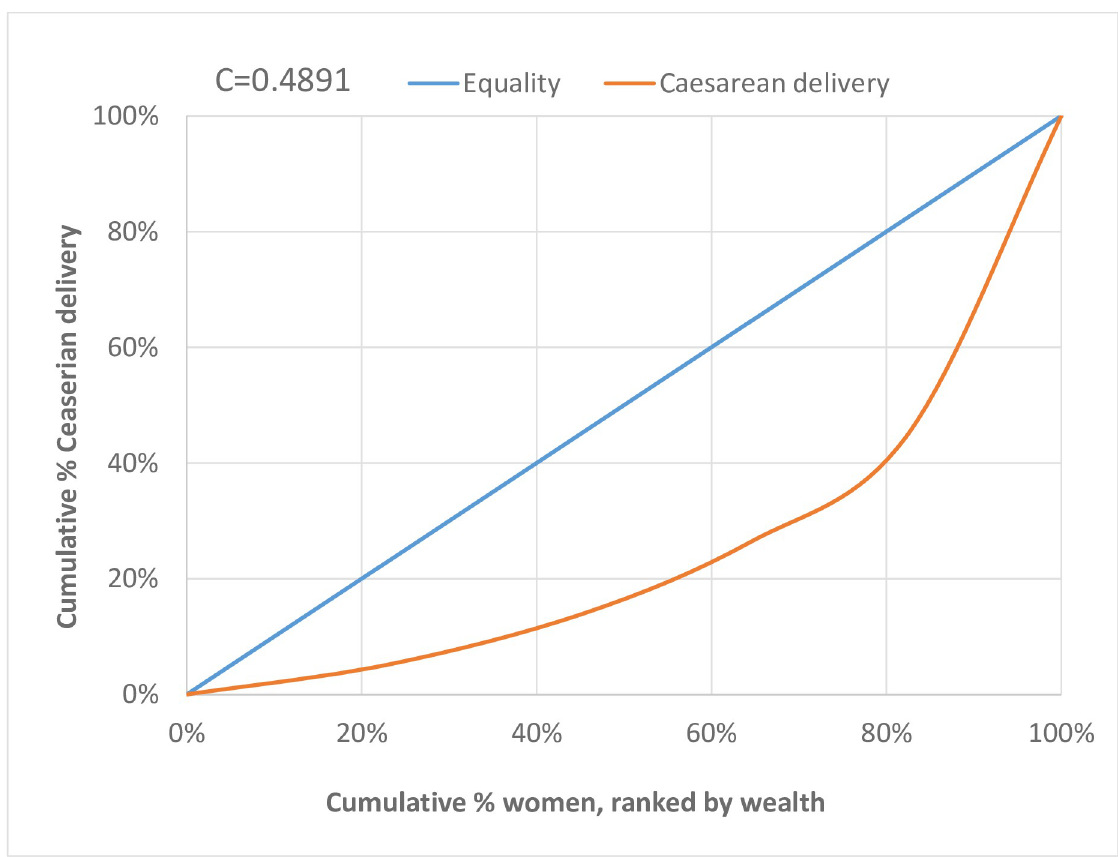
Fig 1. Concentration curve for cumulative caesarean delivery by wealth quintile in Nigeria.